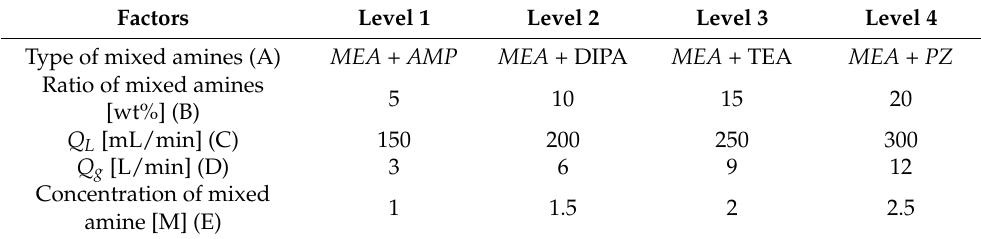
Table 2. Factors and levels conducted in this study to examine the absorption and mass transfer phenomena of CO 2 .